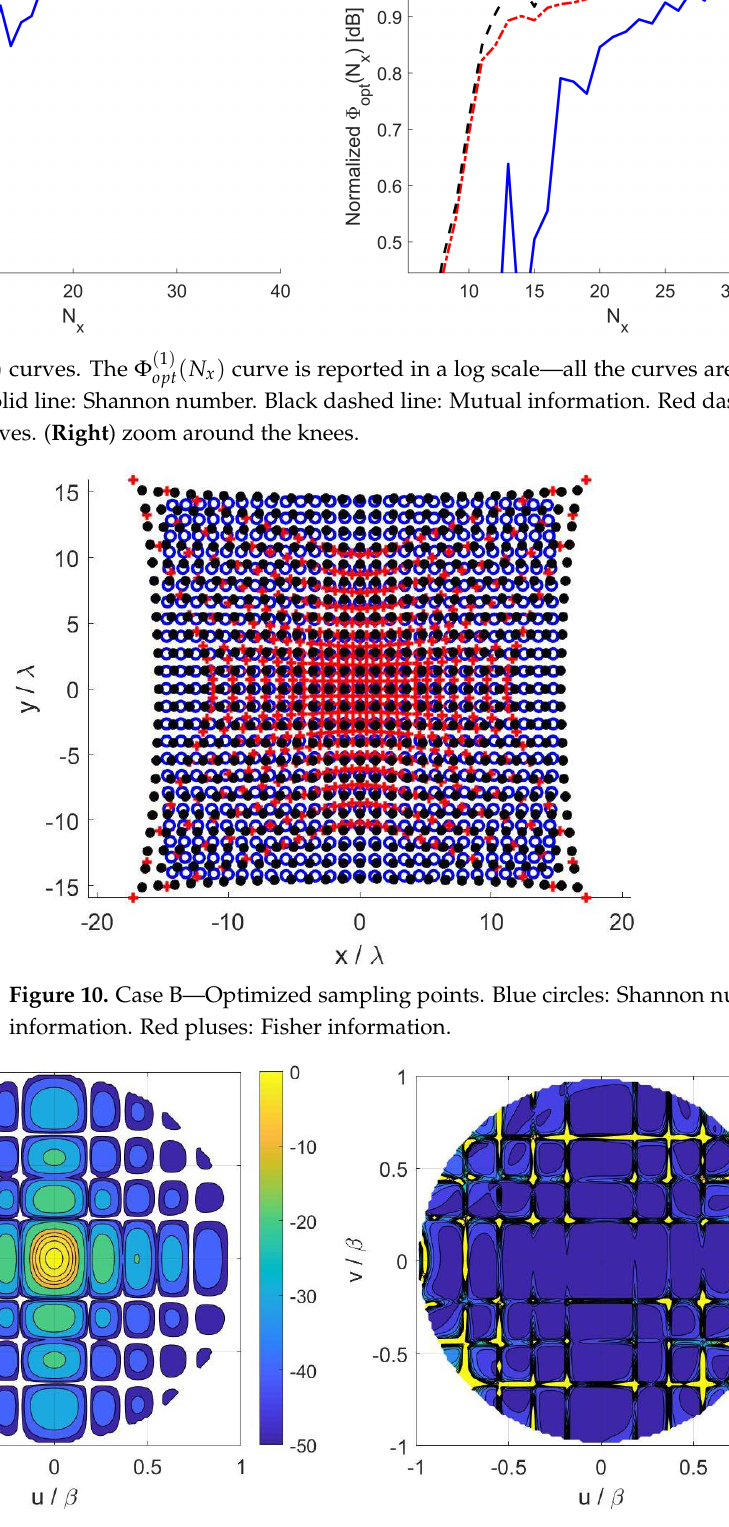
Figure 11. Case B—( Left ) contour plot of the reference FFP. ( Right ) percentage error of the FFP retrieved in the Shannon number